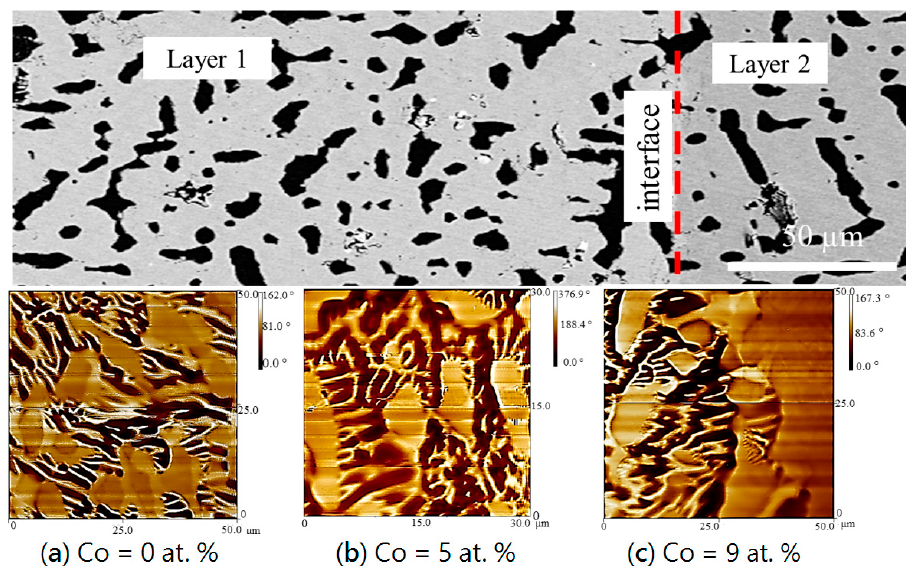
Figure 10. Microstructure ( top ) and three MFM images ( a – c ) obtained from layer 1 to the interface with layer 2 of DC1.